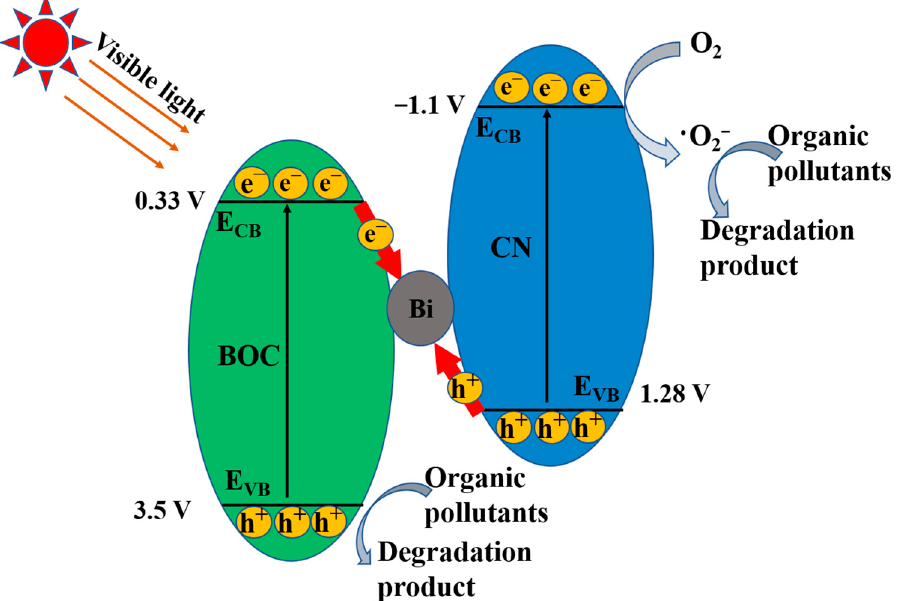
Figure 8. The schematic of BOC-CN-Bi Z-scheme heterojunction by degrading RhB.